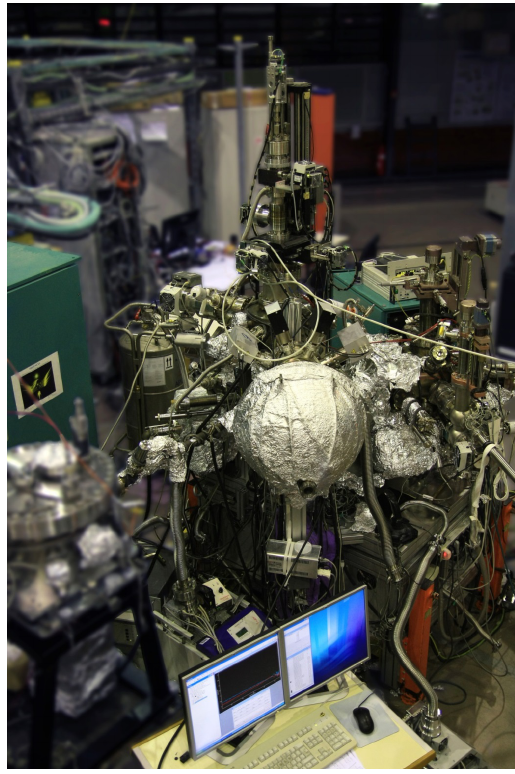
Figure 1: View of the PHOENEXS